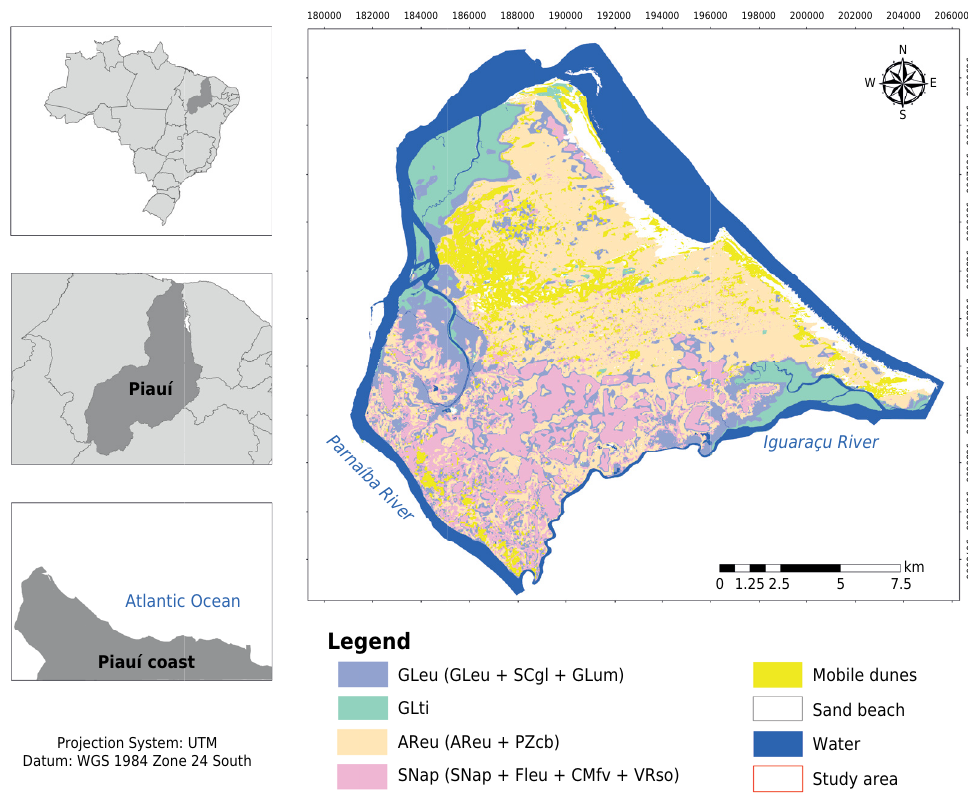
Figure 6. Digital soil mapping generated from the data matrix 1. GLeu: Eutric Gleysol ( Gleissolo Háplico ); SCgl: Gleyic Solonchack ( Gleissolo Sálico ); GLum: Umbric Gleysol ( Gleissolo Melânico ); GLti: Thionic Gleysol ( Gleissolo Tiomórfico ); AReu: Eutric Arenosol ( Neossolo Quartzarênico ); PZcb: Carbic Podzol ( Espodossolo Humilúvico ); SNap: Abruptic Solonetz ( Planossolo Nátrico ); FLeu: Eutric Fluvisol ( Neossolo Flúvico ); CMfv: Fluvic Cambisol ( Cambissolo Flúvico ); VRso: Sodic Vertisol ( Vertissolo Háplico ).